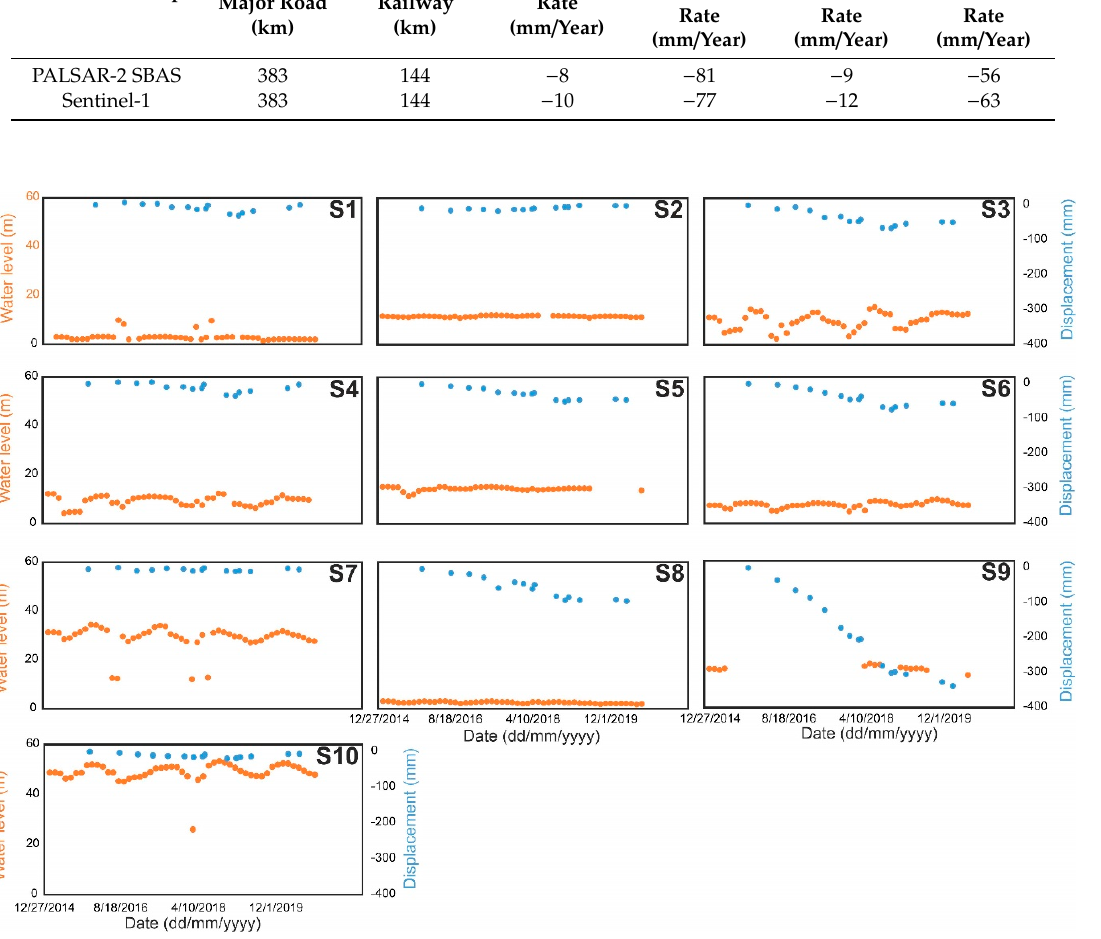
Figure 11. Scatter plot of SBAS mean displacement and mean coherence values at locations of 10 piezometric